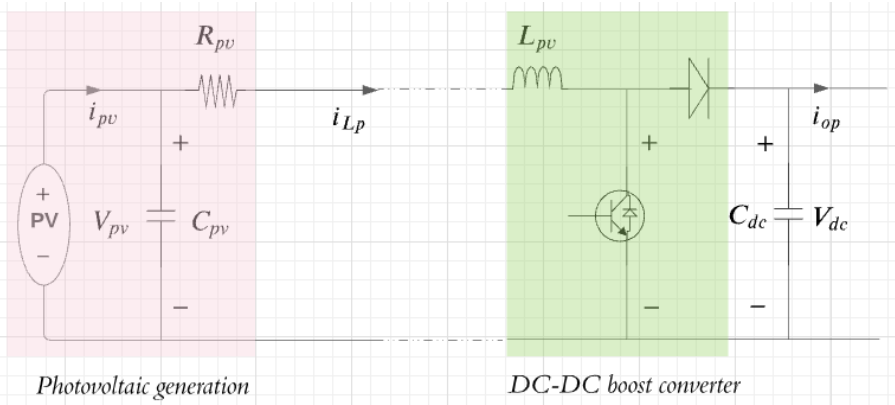
Figure 2. Circuit diagram of DC-bus connected solar photovoltaic panel through DC-DC boost